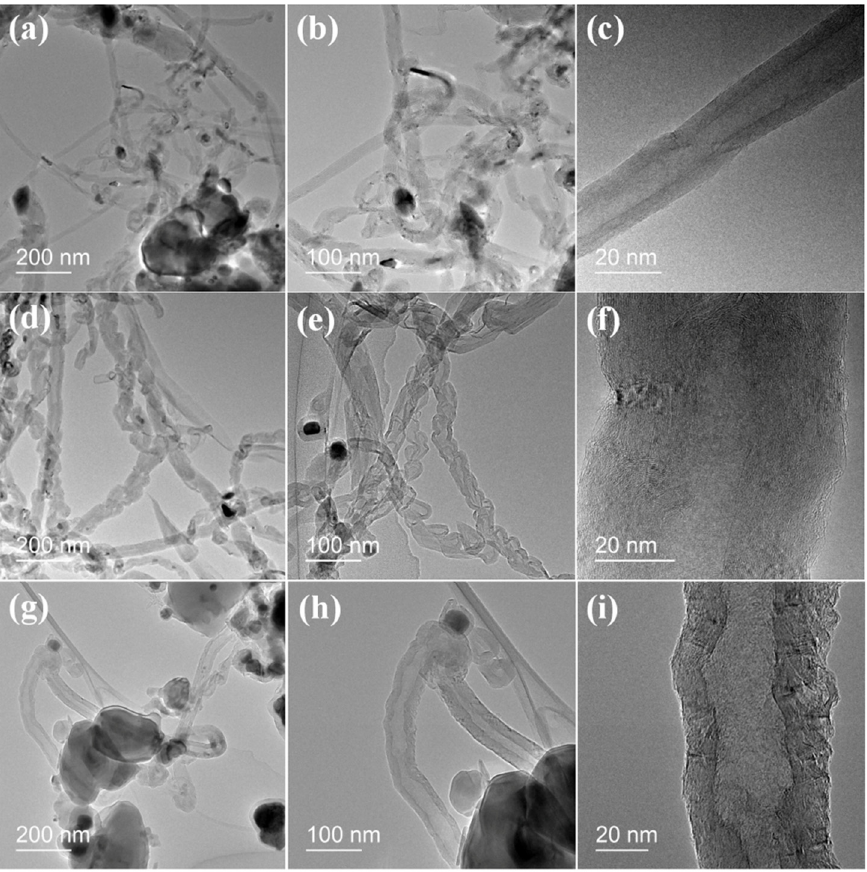
Figure 11. TEM images of CNCs synthesized at 900 ◦ C ( a – c ), 950 ◦ C ( d – f ), and 1000 ◦ C ( g – i ) with the NiCo/ α –Al 2 O 3 catalyst.